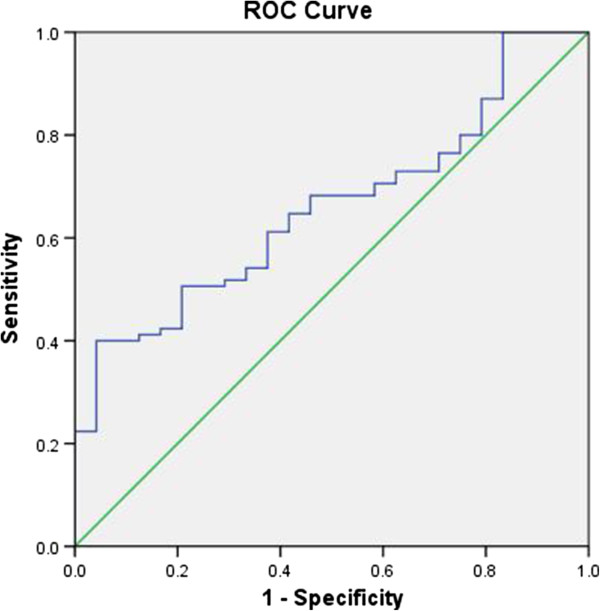
ROC curve of the SPP1 values in pleural effusion. SPP1 in PF from all 109 patients are 24 suffered from benign lung disease and 85 with NSCLC. The cut-off value was calculated to be 1247.90 ng/ml (sensitivity, 40.3%; specificity, 95.8%; area under the curve (AUC), 0.660; 95% confidence interval (CI): 0.550-0 .770). Based on cut-off value the positive predictive value is 97.1%; negative predictive value is 31.1%.